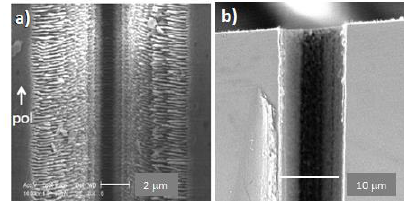
Fig. 1. (a) Transverse view of a waveguide in diamond (b) Cloud of NVs emission along the waveguide mode